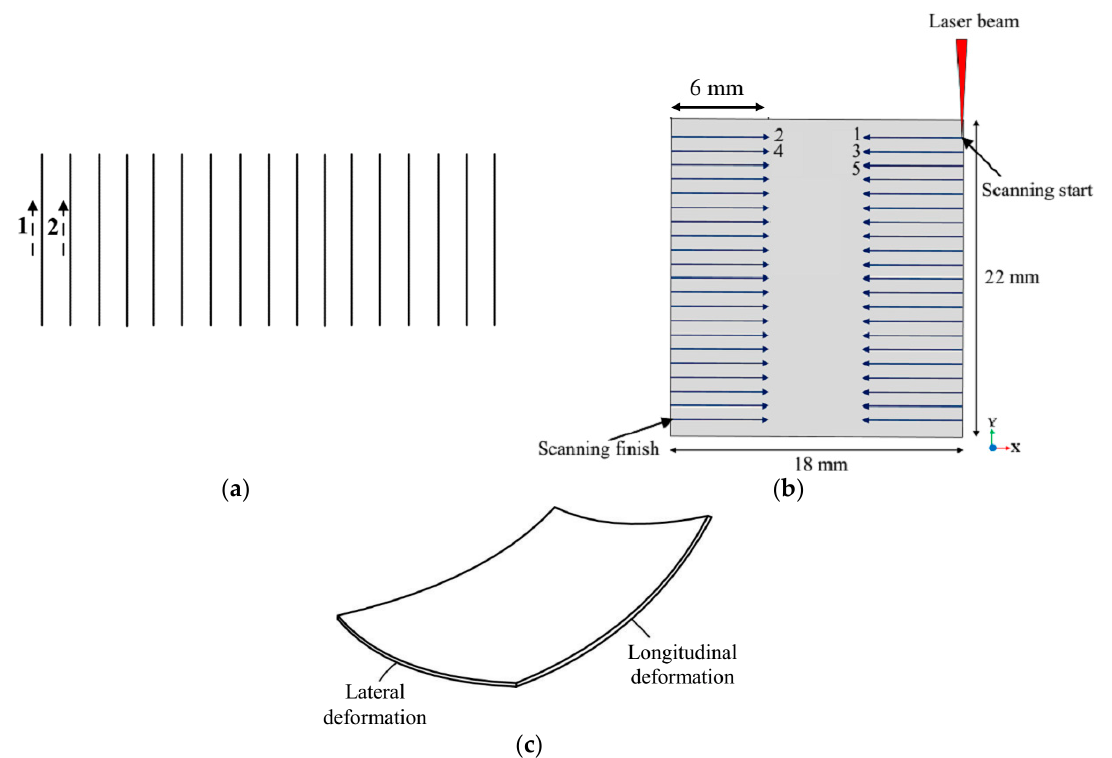
Figure 1. ( a ) Raster scanning strategy; ( b ) applied raster scanning strategy; and ( c ) depiction of the desired shape.